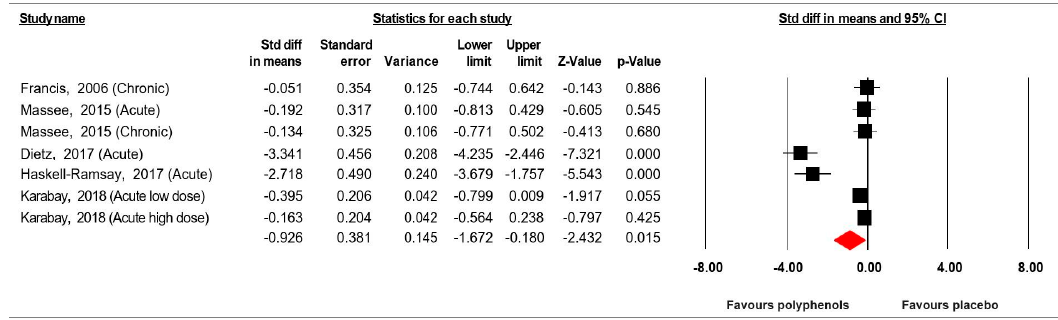
Figure 2. Forest plot of studies investigating the effect of (poly) phenols-rich supplementation on simple reaction time (SRT). The black symbol for std diff of each individual study and the red for the std diff of all pooled studies.